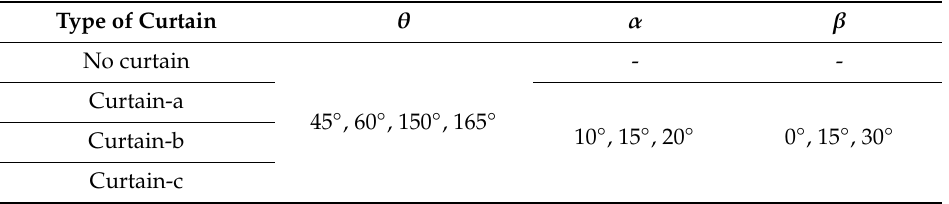
Table 2. List of simulated operating points of the numerical simulation.